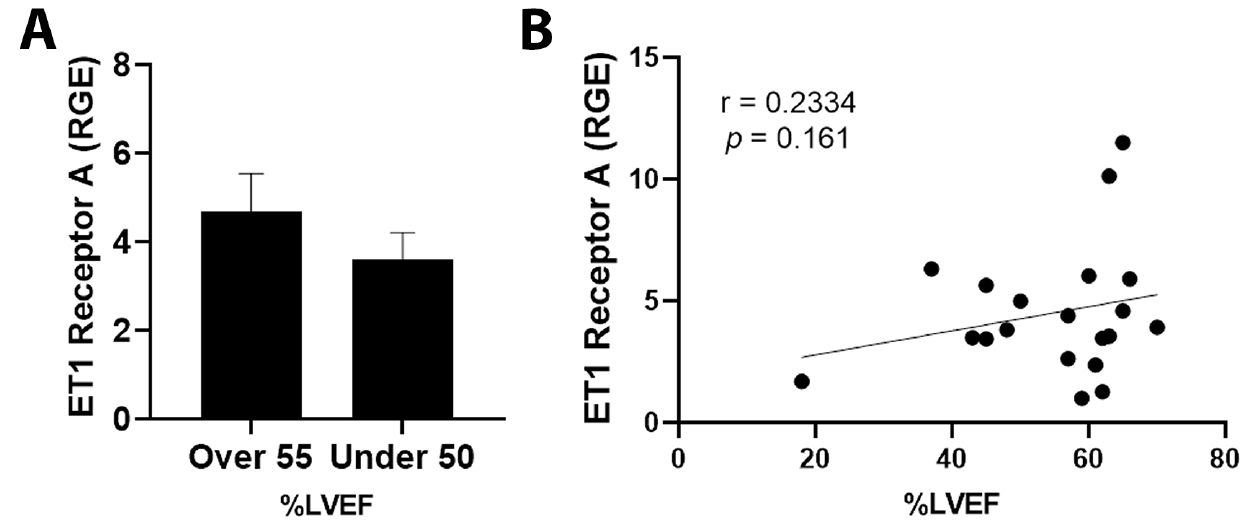
Figure 5. Relationship between LVEF of >55% or ≤50% and ET1 Receptor A in tumor samples. ( A ) Relative gene expression (RGE) of ET1 receptor A by qRT-PCR ( p = 0.1837) compared to the housekeeping gene PUM1. ( B ) Pearson correlation for ET1 Receptor A vs. percentage of LVEF ( p = 0.161). n = 22.